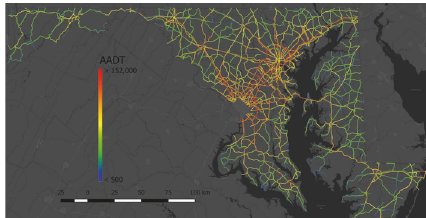
Figure 7: Visual representation of AADT in 2013 for the road links in Maryland.